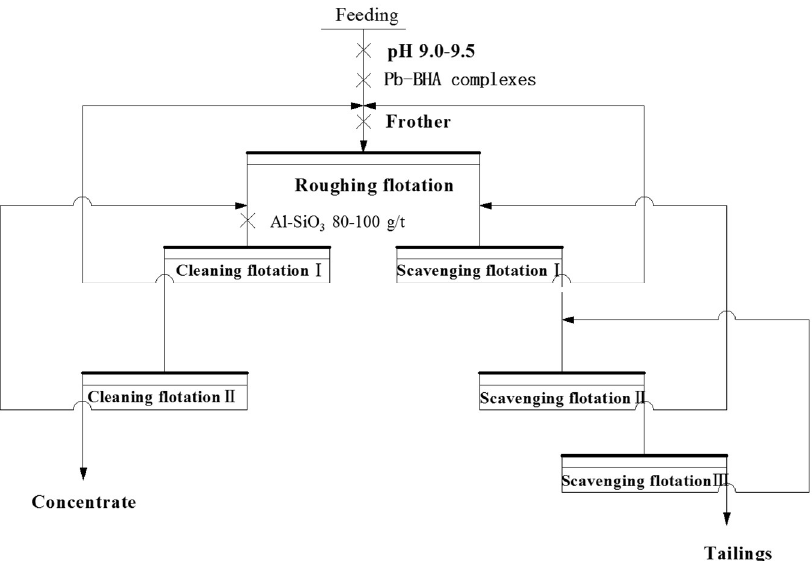
Figure 1. Flotation flowsheet of tungsten minerals using Pb–BHA complexes in Shizhuyuan dressing plant.